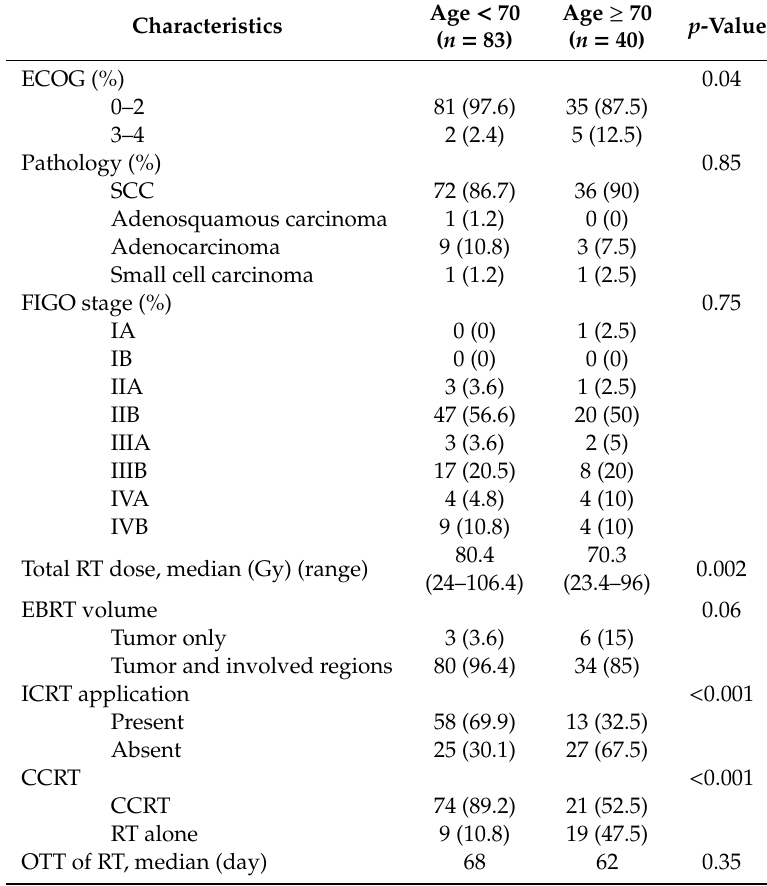
Table 1. Patient